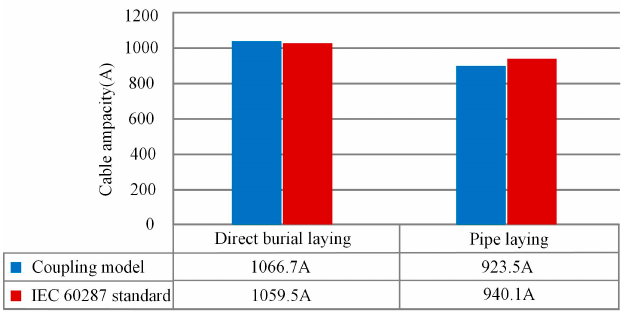
Figure 13. The comparison of the submarine cable ampacity calculated by the IEC 60287 and obtained by the simulation.